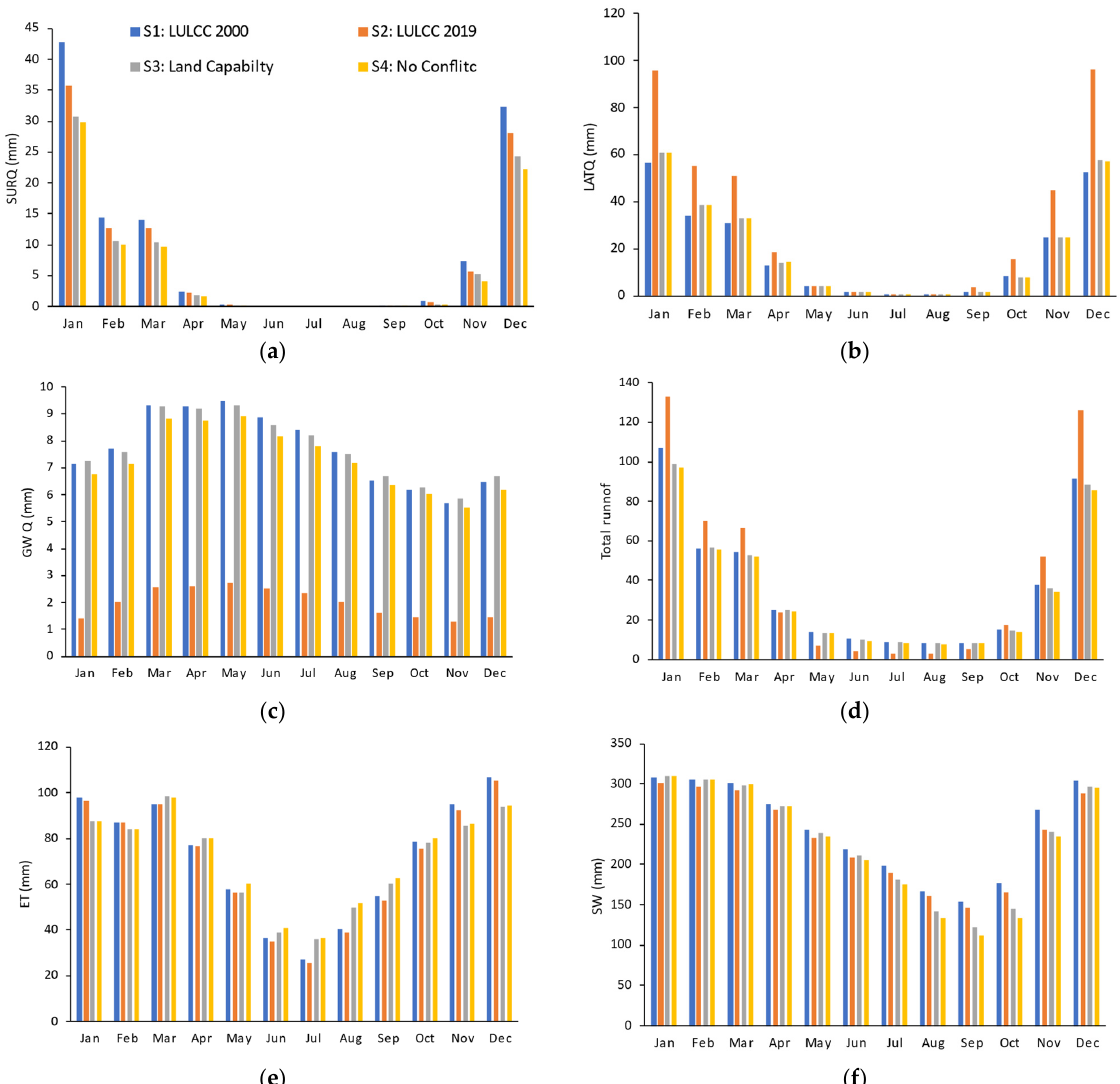
Figure 11. Monthly ( a ) surface runoff (SURQ), ( b ) lateral runoff (LATQ), ( c ) groundwater (GWQ), ( d ) total runoff, ( e ) evapotranspiration (ET), ( f ) soil water (SW), and their monthly changes using SWAT under different land use change scenario soils in the Paraopeba River Basin.